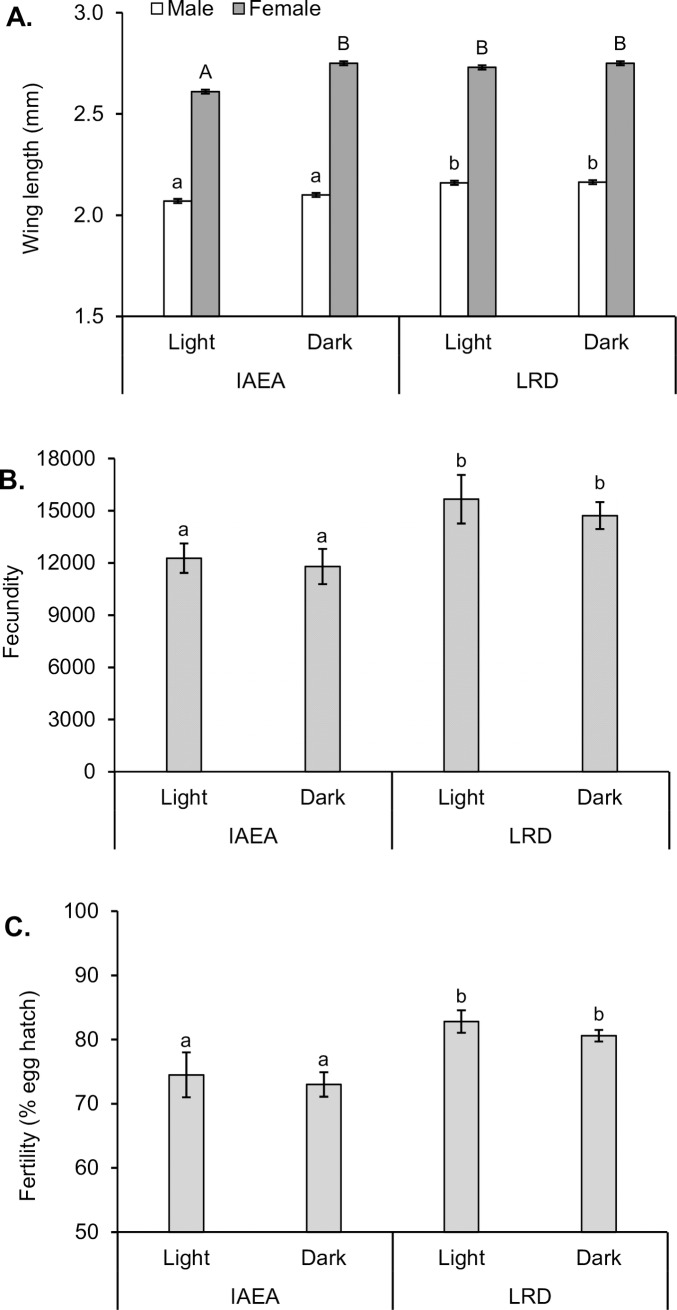
Wing length, fecundity and fertility of Aedes aegypti reared during the larval stage on IAEA or LRD diet under light or dark conditions.(A) Mean wing length of adult male (white columns) and female (gray columns) mosquitoes, (B) Mean fecundity expressed as mean number of eggs laid in each cage of 100 female mosquitoes, (C) Mean fertility expressed as percentage of egg hatch. Columns headed by different letters differed significantly for comparisons among treatments for upper case (female) and lower case (male) letters (A), or lower case letters (B, C) (ANOVA, Tukey, P <0.05). Vertical bars indicate SE in all cases.